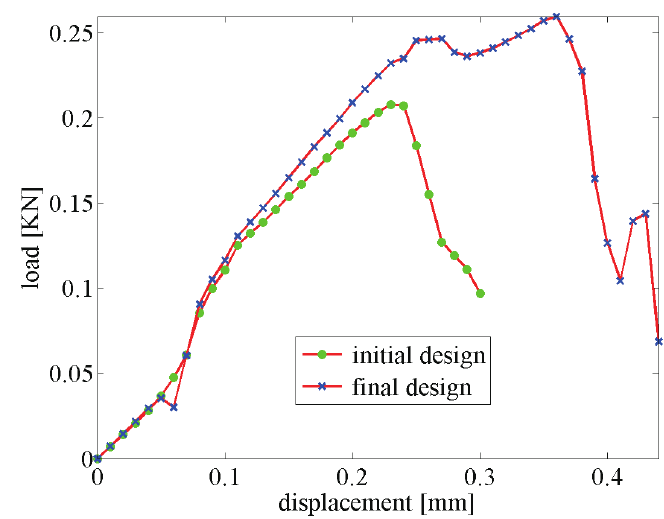
Figure 13. Force–displacement curve of the composites structure subjected to non-symmetric three-point bending.